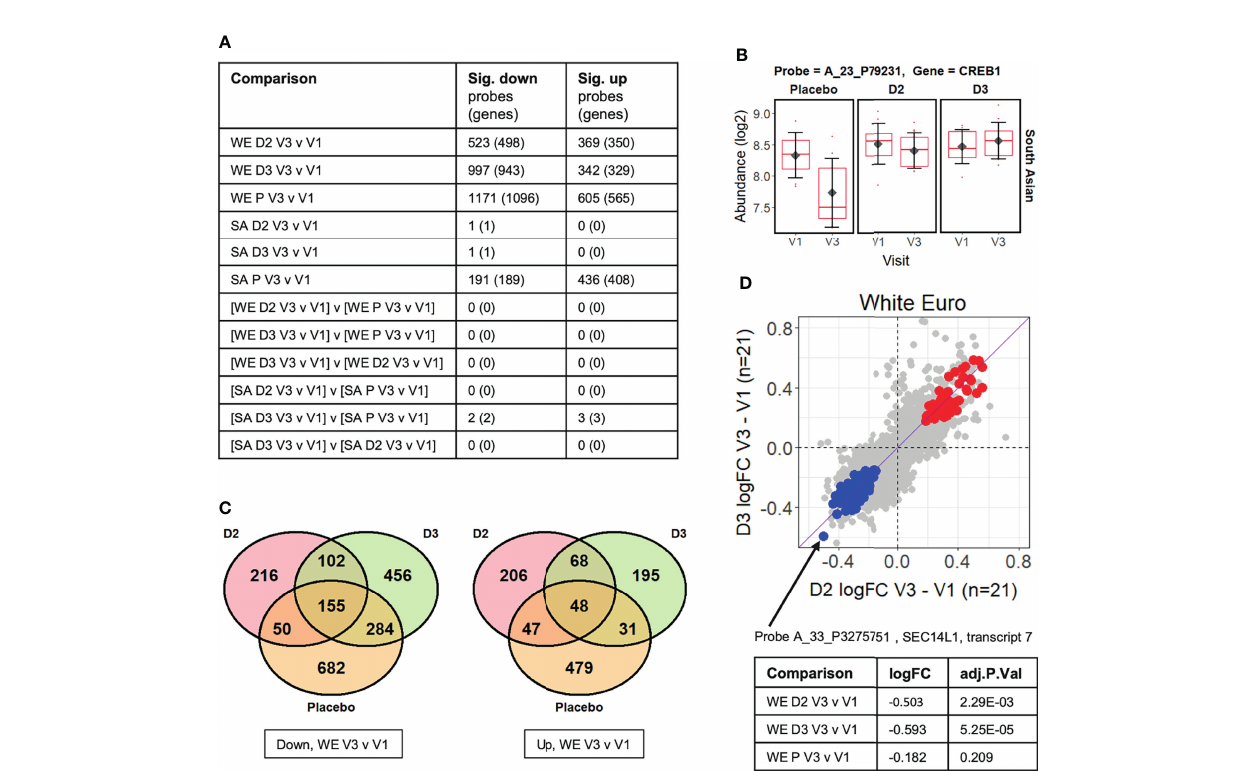
FIGURE 2 | (A) Summary of limma differential expression test results identifying signi fi cant changes (adj.P.Val ≤ 0.05) in transcript probe abundance within and between the experimental groups (see Supplementary Data File 2 for full details). Both the number of unique microarray probes, and the number of unique genome loci they represent, are indicated. WE = “ white European ” ; SA = “ South Asian ” ; D2 = vitamin D 2 treatment group; D3 = vitamin D 3 treatment group; P = placebo group. (B) The CREB1 gene probe signal is signi fi cantly different (adj.P.Val=0.021) between the vitamin D 3 -treated group and the placebo group over the course of the V1 to V3 study period in the South Asian cohort (i.e. [SA D3 V3 v V1] v [SA P V3 v V1] comparison from Figure 2A ). (C) Venn diagrams showing the numbers of probes in the white European (WE) cohort that are speci fi cally signi fi cantly (adj.P.Val ≤ 0.05) down- or up-regulated in V3 compared to V1 in each treatment group. (D) Comparison of the log 2 fold-changes (FC) in abundance occurring from V1 to V3 in the WE cohort in the D 2 and D 3 treatment groups. Probes signi fi cantly up-regulated in both D 2 and D 3 groups but not the placebo are coloured red, while those similarly down-regulated are shown in blue